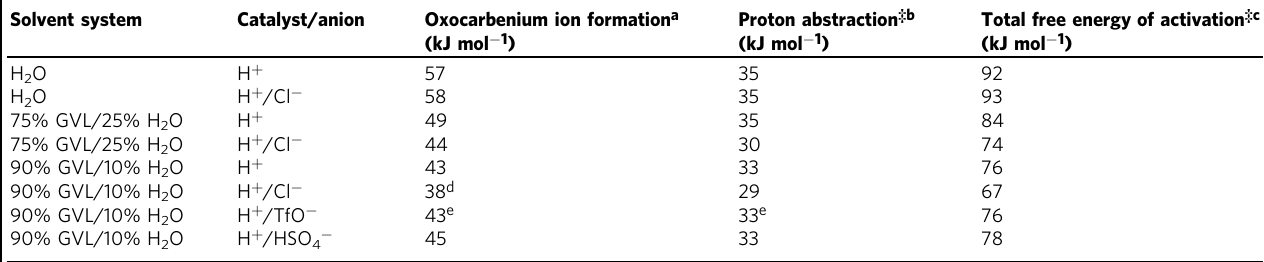
Table 3 AIMD-calculated reaction free energies for fructose dehydration Solvent system